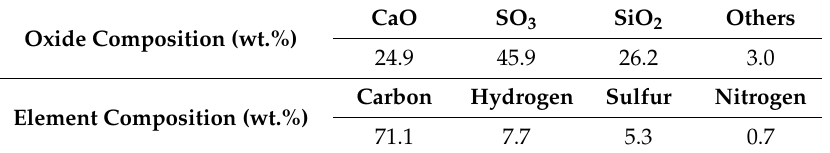
Table 3. The XRF and elemental analysis results of the polymer powder (unit: wt.%).